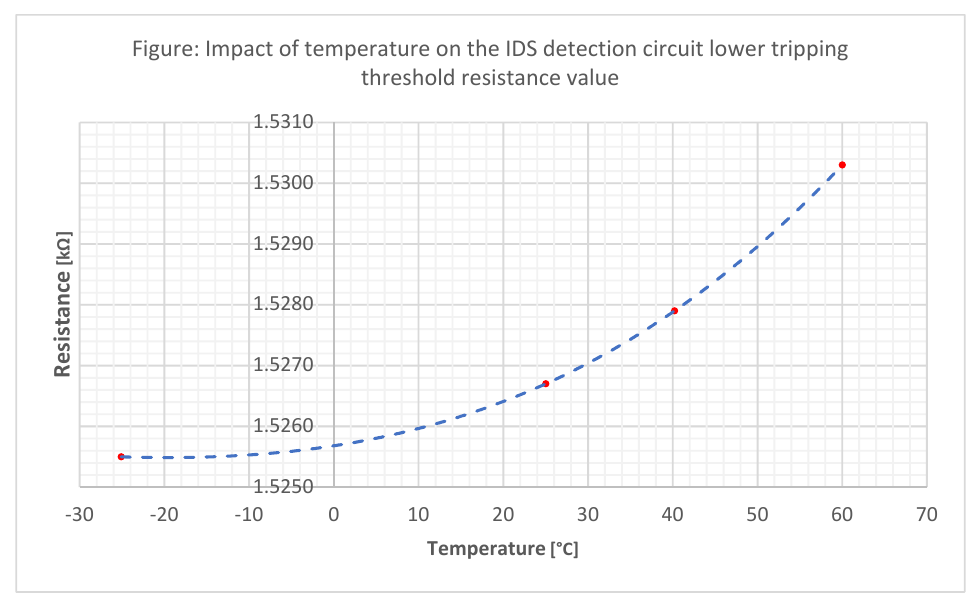
Figure 8. Impact of temperature of a parametric IDS circuit lower tripping threshold resistance value.